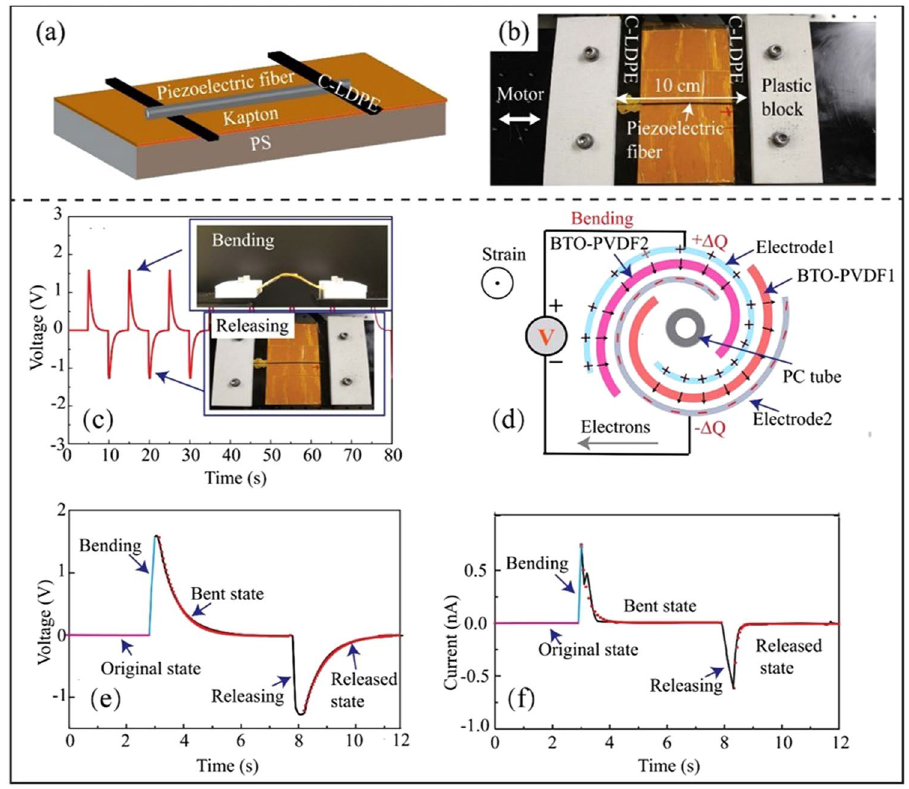
Figure 5. Design and working principles of the fiber-based piezoelectric generators. ( a ) Schematic of a BTO- PVDF fiber-based generator. ( b ) Setup for testing of microstructured fiber generator. ( c ) Measured voltage response of the piezoelectric fiber under cycling bending at 0.1 Hz. The top and bottom insets show photographs of the fiber during bending and release, respectively. ( d ) When mechanical strain is applied along the fiber by bending, the polarization density of the BTO-PVDF layer is changed and the electrons are forced to flow from one electrode to the other, thus generating voltage differential. ( e , f ) The open-circuit voltage ( e ) and the short- circuit current ( f ) of the piezoelectric fiber during the bend and release actions. Relaxation of the short circuit current and open circuit voltage on time can be described as single exponential decays with two distinct time constants (red curve